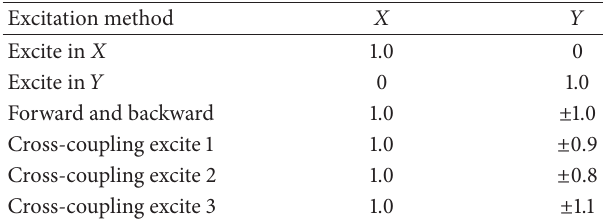
Table 2: Current coefficient in the experimental test.